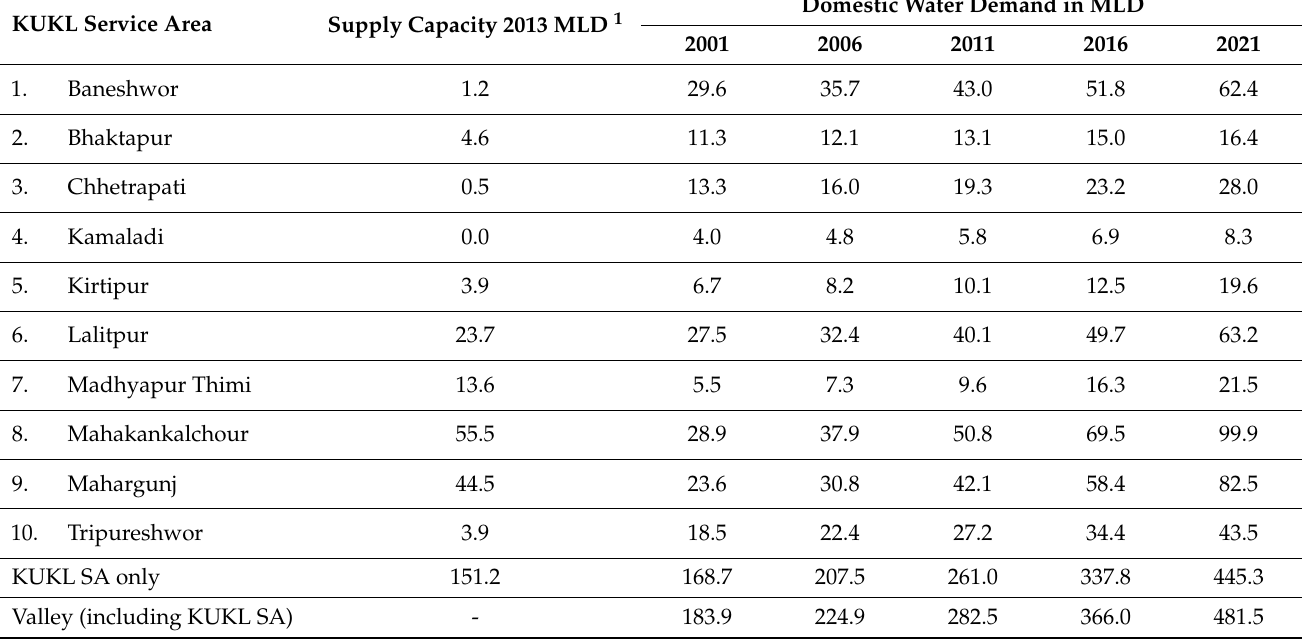
Table 1. KUKL (Kathmandu Upatyaka Khanepani Limited) service area estimated demand of water using BIS (Bureau of Indian Standard) guidelines. KUKL Service